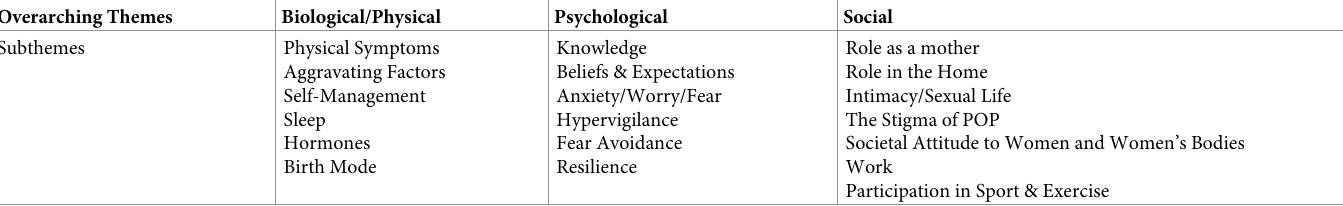
Table 4. Overarching themes and